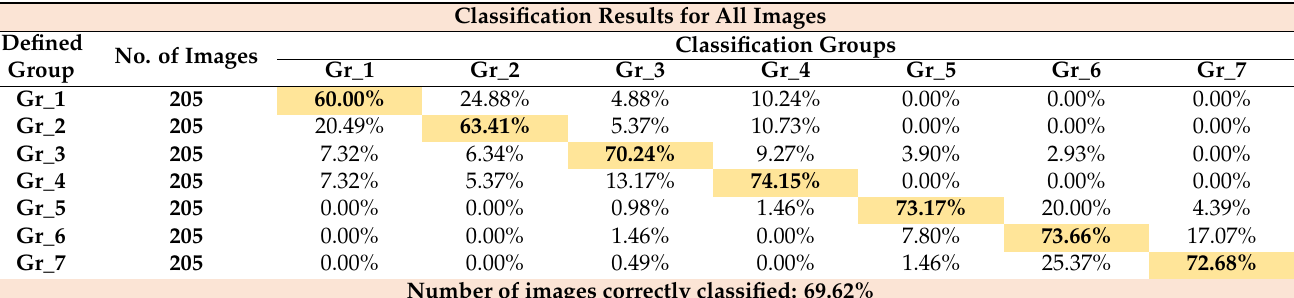
Table 2. Classification results for all images collected during the experiments. Classification Results for All